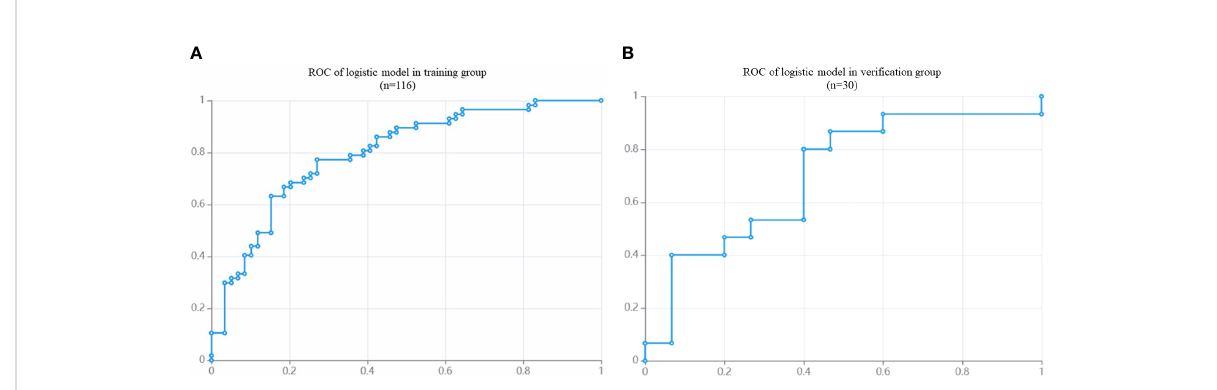
FIGURE 4 The ROC of DM in NPC patients based on MRI radiomics model. (A) : the AUC of training group (n = 116) is 0.80. (B) : the AUC of validation group (n = 30) is